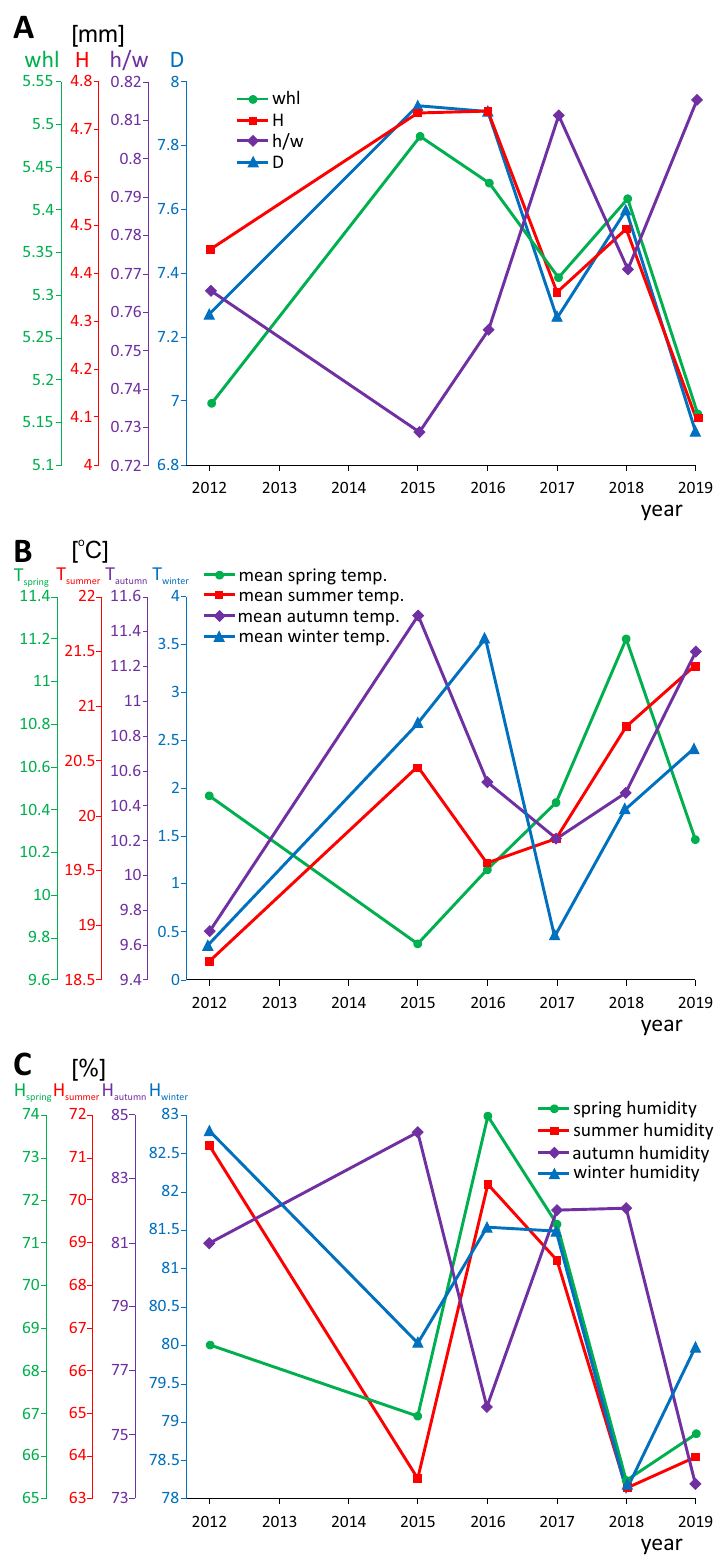
Figure 2. Changes in: mean values of selected morphometric features of shells collected in various years in Wrocław ( A ) as well as the mean temperature ( B ) and the relative humidity ( C ) recorded in four seasons in Wrocław in eight-year period. Abbreviations: D—shell diameter (in mm), H—shell height (in mm), h/w— aperture height/width ratio, whl—number of whorls. The summary statistics for A is included in Table S1 and original data in Table S10 in Additional file